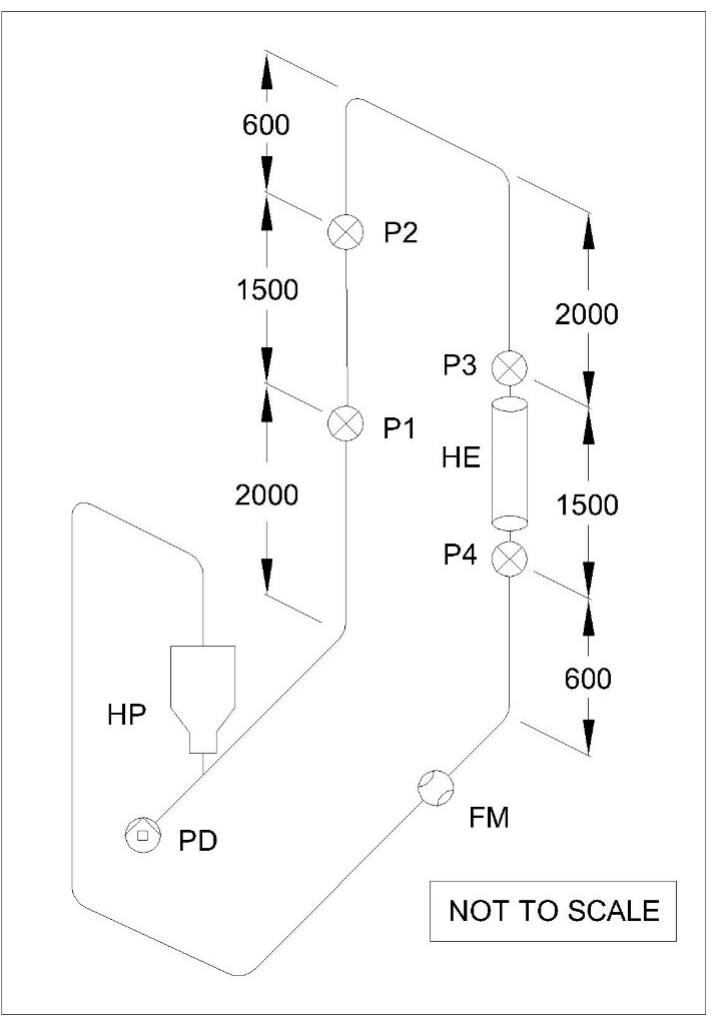
Figure 6. The flow loop test experimental apparatus (all dimensions are in mm). PD—positive displacement pump; HP—hopper; P1, P2, P3, and P4—pressure gauges; HE—heat exchanger; FM— flow meter.